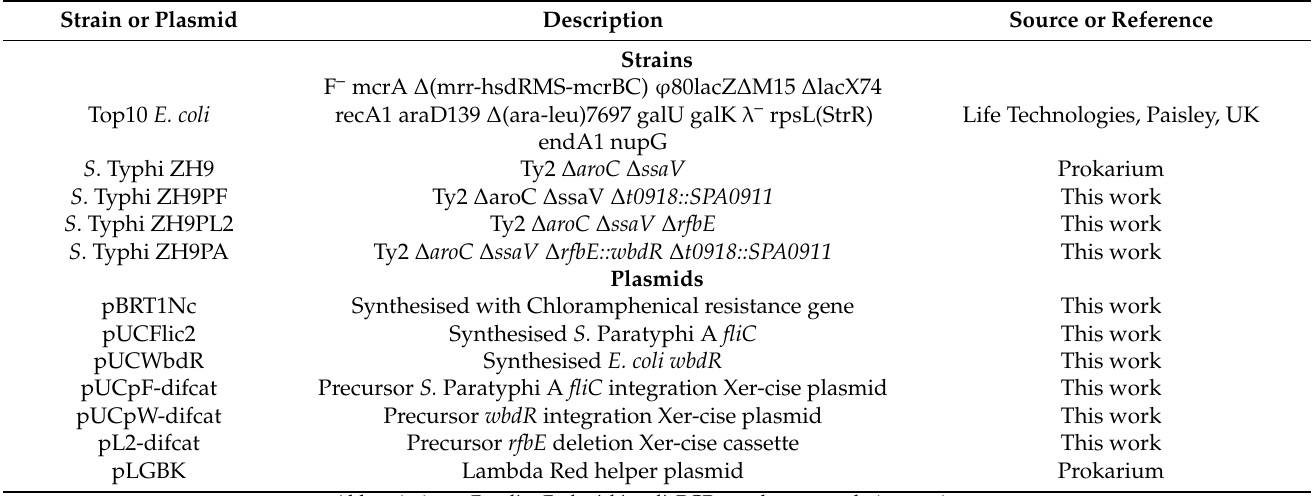
Table 1. Bacterial strains and plasmids used directly in this